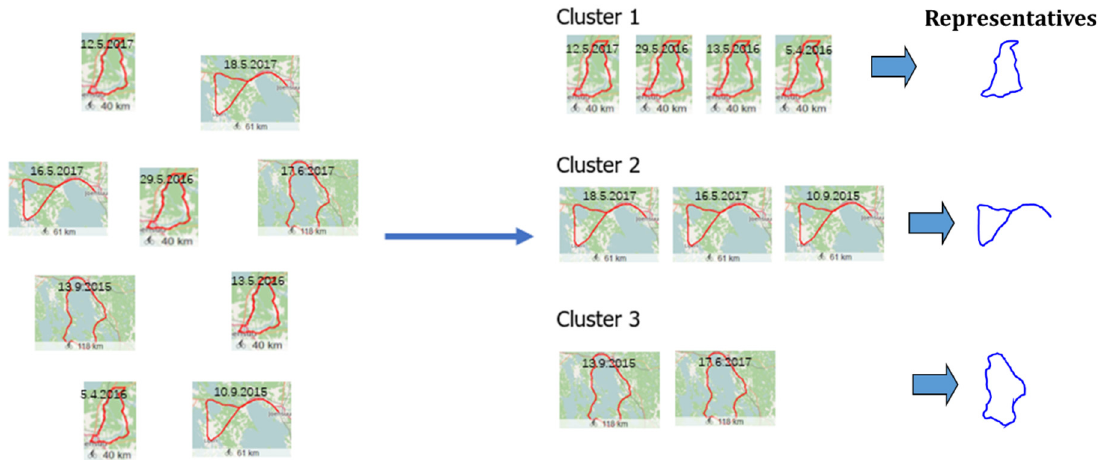
Figure 2. Averaging is needed to find representatives for trajectory clusters. This can be challenging as the trajectories may have complex shapes.